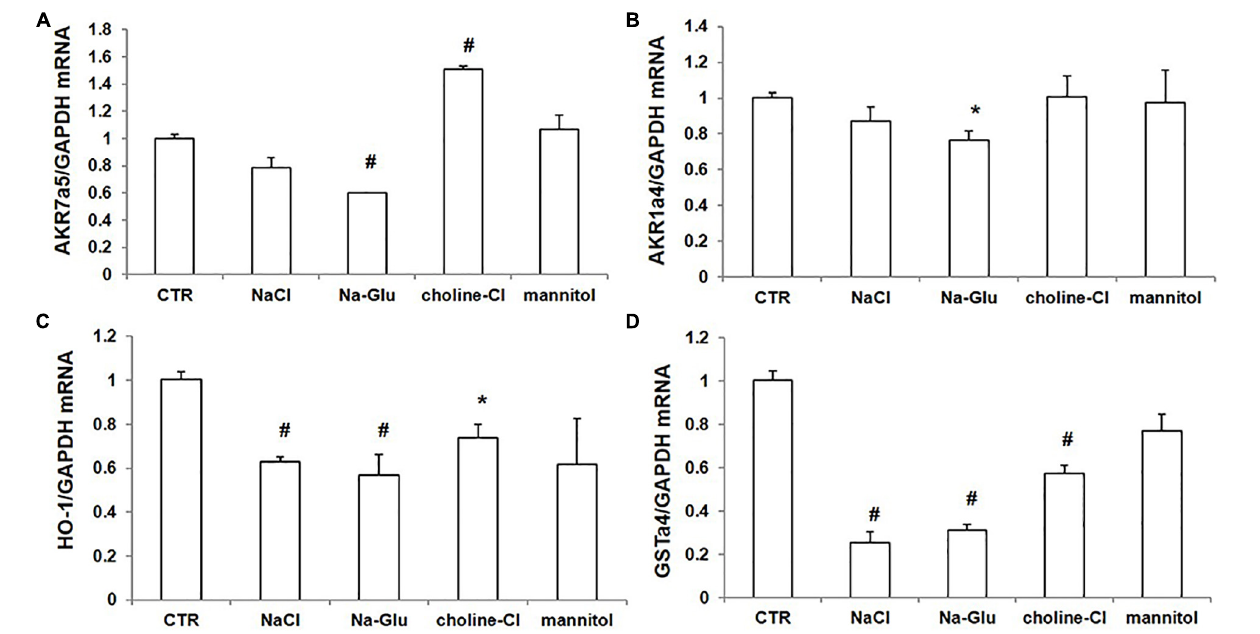
FIGURE 7 | mRNA expression of Nrf2 target genes in mpkCCD cells after treatments of NaCl, Na-Glu, choline-Cl, and mannitol. (A) qRT-PCR analysis of AKR7a5. (B) qRT-PCR analysis of AKR1a4. (C) qRT-PCR analysis of HO-1. (D) qRT-PCR analysis of GSTa4. The presented data are means ± SE. n = 3 per group. ∗ p < 0.05 vs. CTR (control); # p < 0.01 vs. CTR (control).